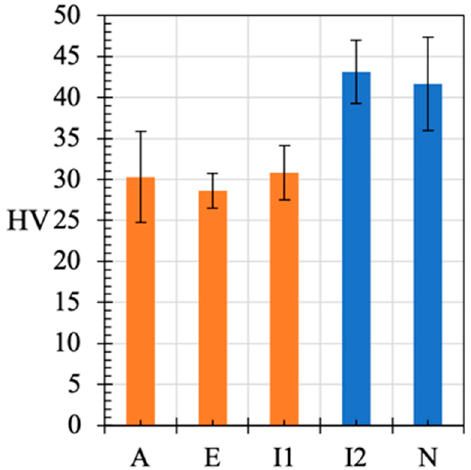
Figure 10. Vickers microhardness numbers for samples on the diagonal of parameter matrix (i.e., those with same hatch distance and point distance). Orange series and blue series indicate samples belonging to the first batch and to the second batch, respectively.